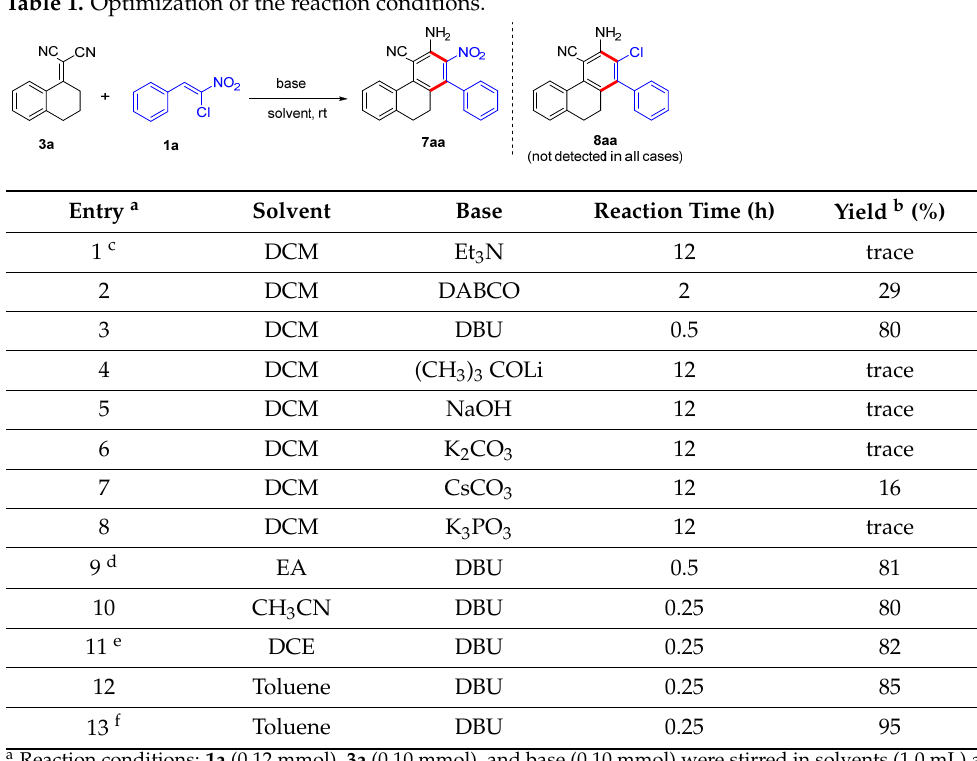
Table 1. Optimization of the reaction conditions.